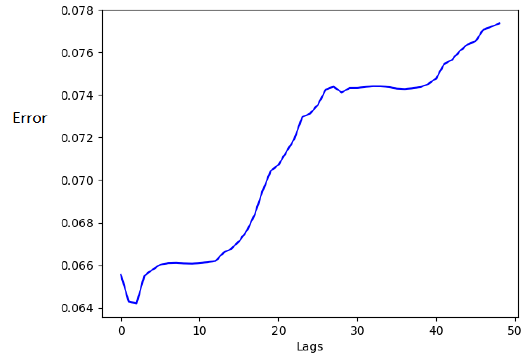
Figure 2. Selection of the number of lags.